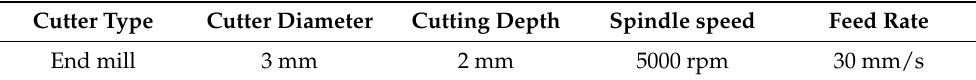
Table 9. Cutting parameters selected for CNC cutting of high-density polystyrene columns. Cutter